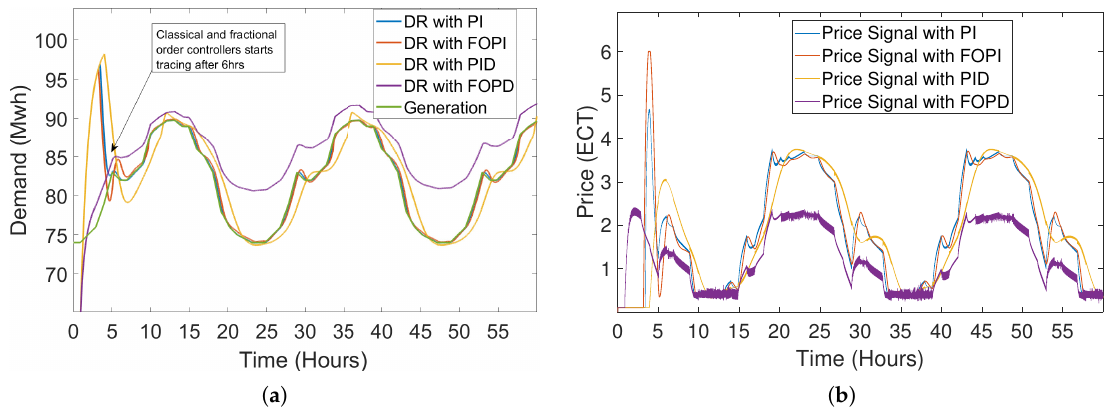
Figure 19. Closed-loop elastic demand control using PI, FOPI, PID and FOPD controllers: ( a ) demand response; ( b ) price response.